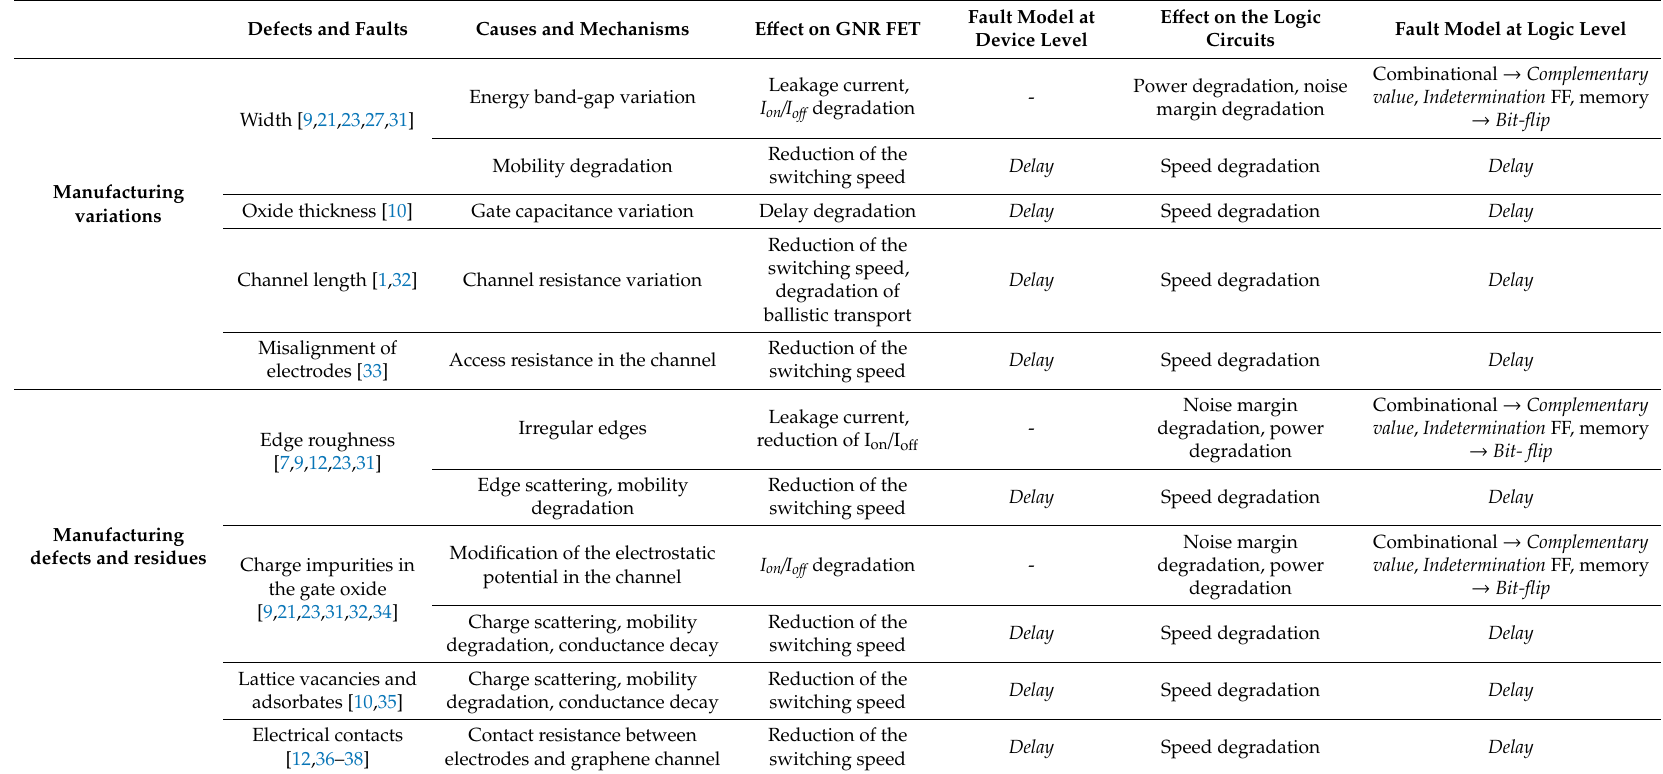
Table 1. Fault causes, mechanisms, and models of GNR FET logic